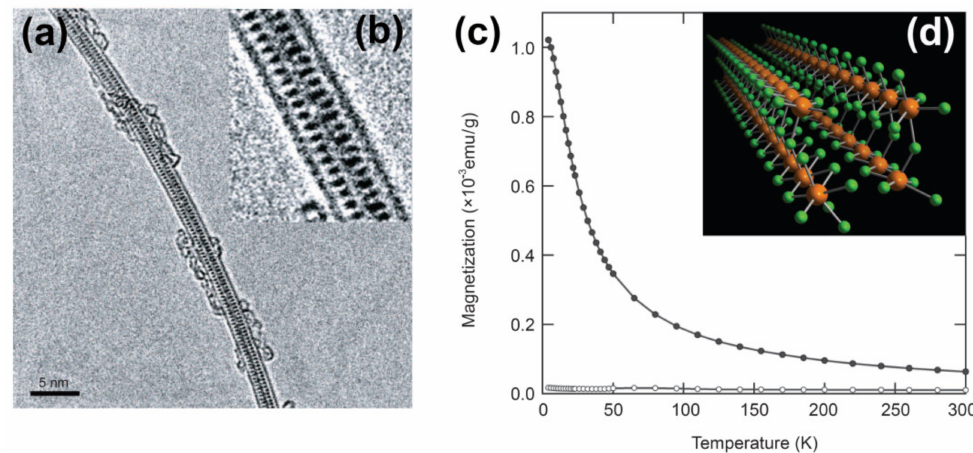
Figure 2. ( a ) The TEM image of the ErCl 3 -filled SWCNTs. ( b ) The high-magnification photo of the filled SWCNTs. ( c ) The magnetization of ErCl 3 -filled SWCNTs and purified empty SWCNTs as measured by SQUID magnetometry. Filled and open circles represent the magnetization of ErCl 3 -filled SWCNTs and purified empty SWCNTs. ( d ) The structural model of the encapsulated nanocrystal. Reproduced from [99]. Published by SpringerNature under a Creative Commons Attribution Non-commercial